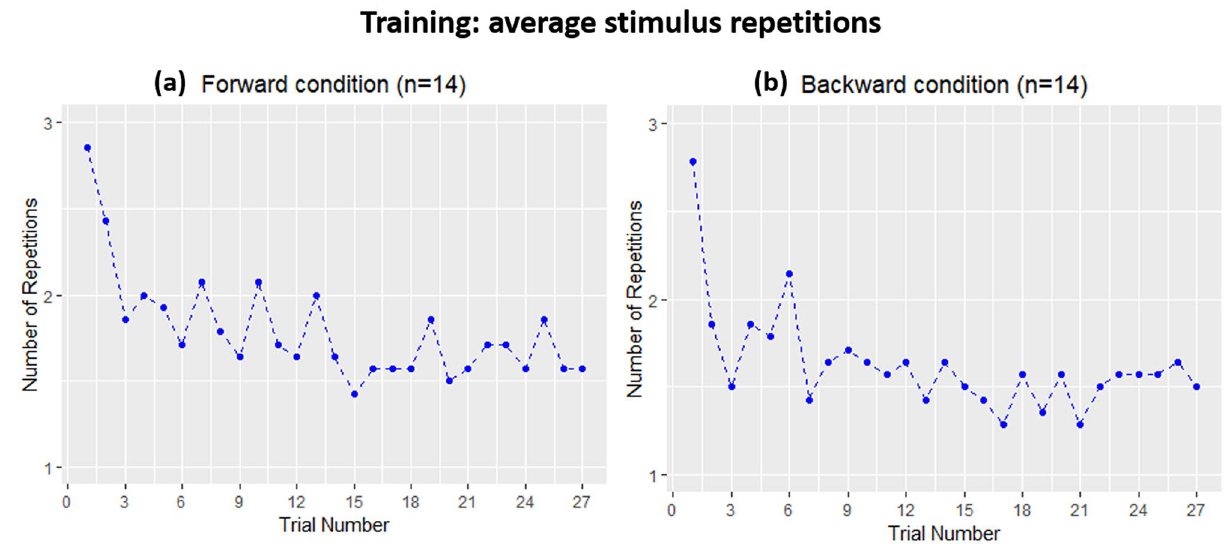
Figure 2. Average number of stimulus repetitions before providing the correct response as a function of trial number during training (~ 10 min). ( a ) Blindfolded sighted participants in the forward vision condition (n = 14). ( b ) Blindfolded sighted participants in the backward vision condition (n = 14). During the short training, the average number of repetitions before providing the correct response decreased across trials in both conditions, suggesting that the training was effective in teaching to correctly interpret the algorithm. This Figure was created using R Core Team (2018). R: A language and environment for statistical computing. R Foundation for